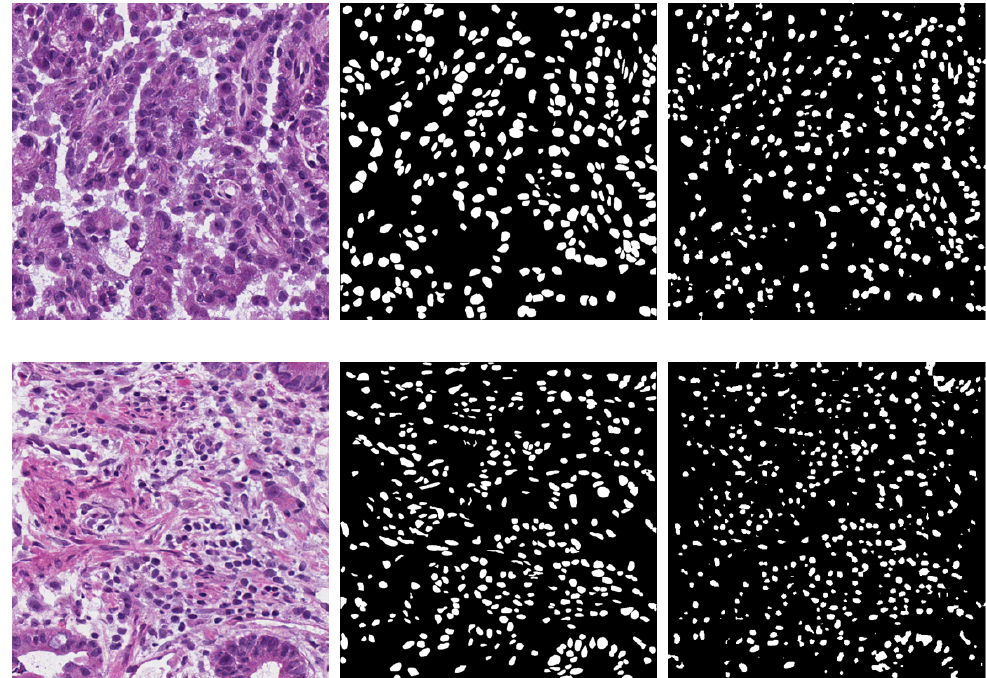
Figure 3. Semantic segmentation output for nuclei images. ( Left ) Original image. ( Middle ) Ground truth. ( Right ) Prediction of experiment (b) with DeepLab v3+ and backbone